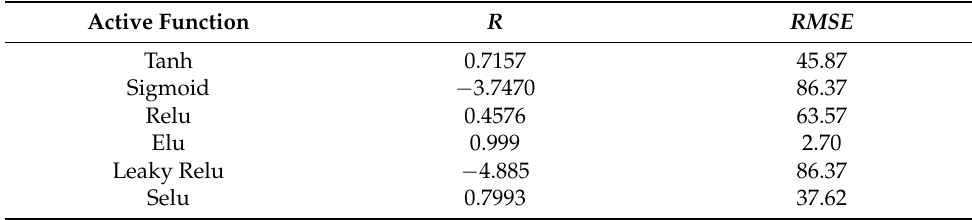
Table 3. The effect of activation function on the